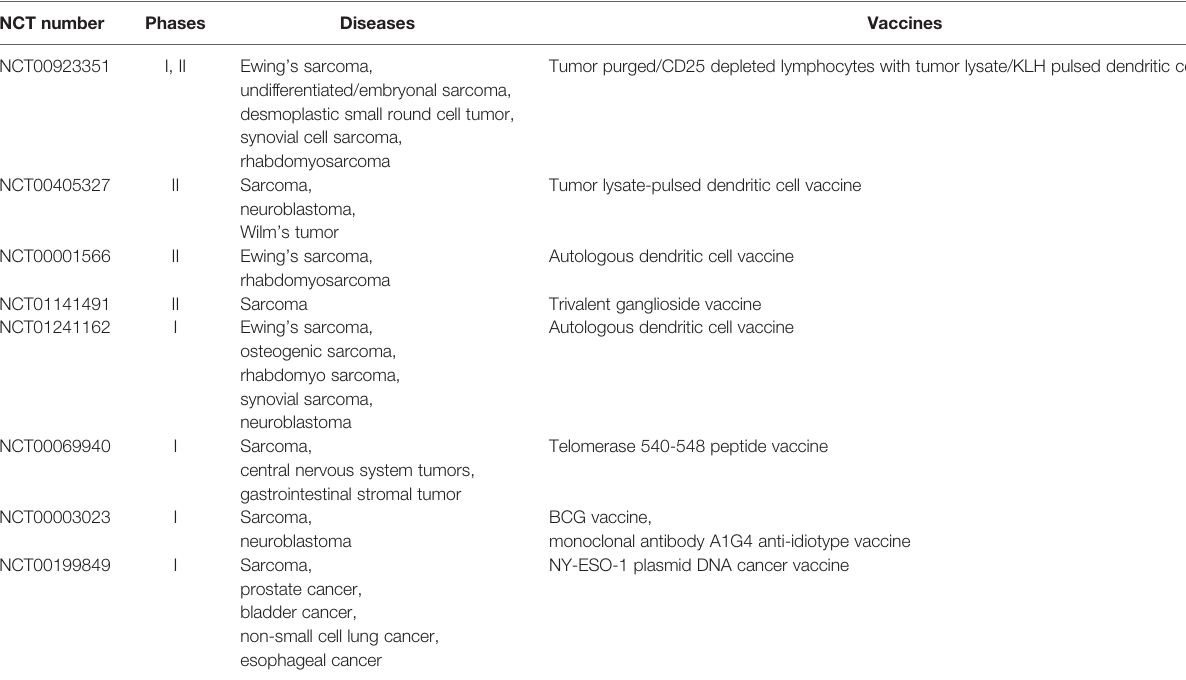
TABLE 1 | Clinical trials of anti-tumor vaccines in